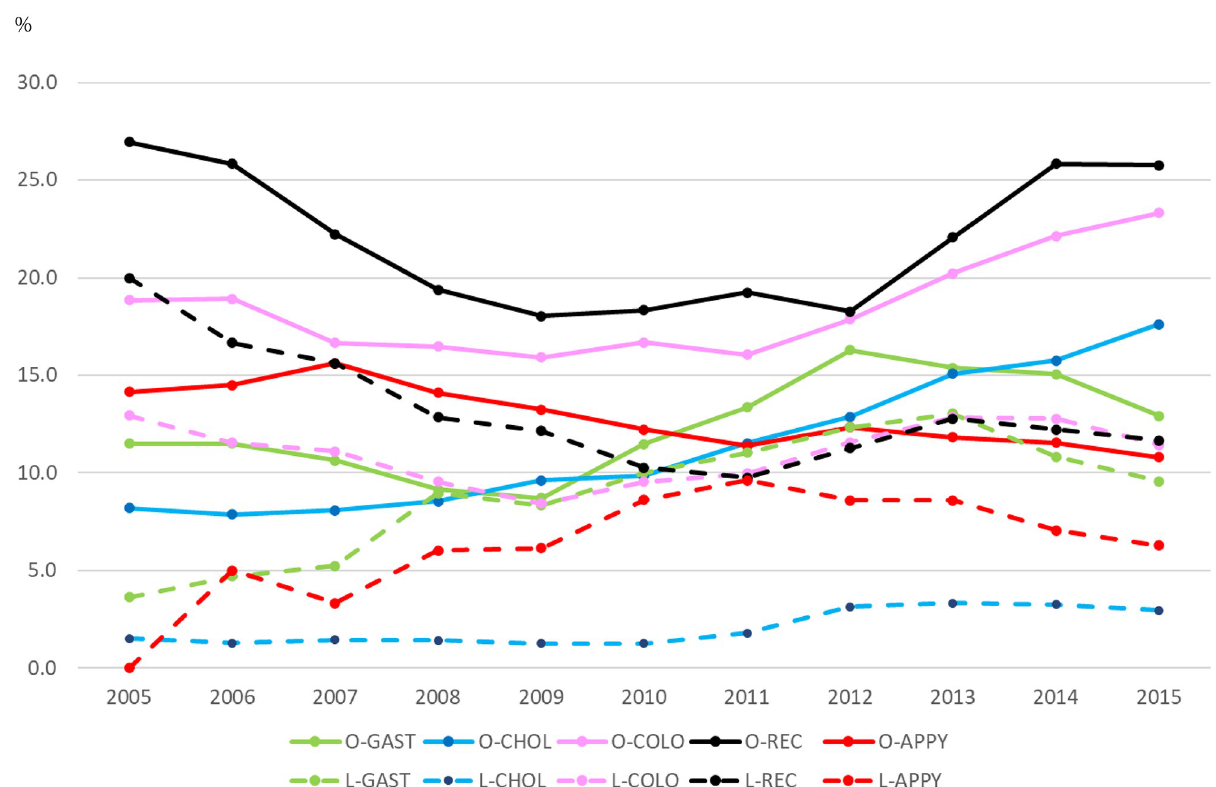
Fig 2. Three-yearly SSI rates average by surgical procedure, 2003–2015.